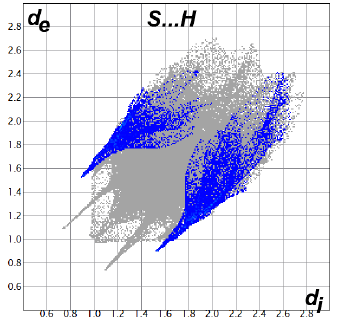
Figure 6. Summary of the intermolecular interactions and their percentages in the crystal structure of the studied compound.